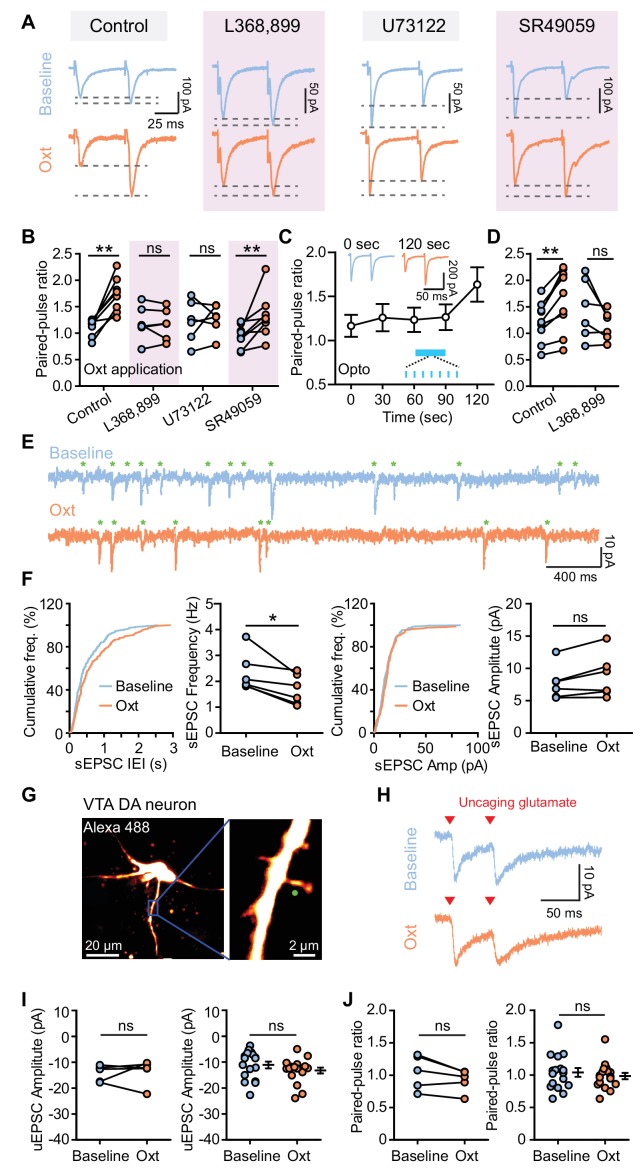
Oxytocin dampens excitatory synaptic transmission by presynaptic mechanisms.(A) Traces from VTA DA neurons showing pairs of EPSCs (50 ms ISI) during baseline (top) and following oxytocin application (bottom). From left to right, example traces reflect: the control condition with no additional compounds, the OxtR antagonist L368,899, the PLC blocker U73122, and the V1aR antagonist SR49059. Traces for each neuron are normalized to the amplitude of the first evoked response in the baseline condition. (B) Summary results show paired-pulse ratio during baseline and following oxytocin application in control condition, in the presence of OxtR antagonist L368,899, PLC blocker U73122, and V1aR antagonist SR49059 separately. **p<0.01, Wilcoxon matched-pairs signed rank test. For each condition respectively, n = 8 neurons from six mice, 6 neurons from five mice, 6 neurons from four mice, and 8 neurons from five mice. (C) Summary results show PPR change of the evoked EPSC of VTA DA neurons in response to light stimulation (marked in blue). n = 9 neurons from six mice. Insets show example pairs of EPSCs (50 ms ISI) from one VTA DA neuron at 0 s (before light stimulation) and 120 s (after light stimulation). (D) Summary data for light stimulation-induced EPSC PPR changes with and without OxtR antagonist (L368,899). **p<0.01, Wilcoxon matched-pairs signed rank test, n = 9 neurons from six mice for control condition, n = 6 neurons from four mice in the presence of OxtR antagonist. (E) Example traces show spontaneous EPSCs (sEPSCs, marked with green stars) during baseline (top) and following oxytocin application (bottom). (F) Left: distributions of sEPSC inter-event intervals (IEI) during baseline and following oxytocin application, with summary data for sEPSC frequency. Right: distributions of sEPSC amplitudes and summary data for sEPSC amplitude during baseline and oxytocin application. *p<0.05, Wilcoxon matched-pairs signed rank test, n = 6 neurons from five mice. (G) Left: projection of a z-stack from a VTA DA neuron filled with Alexa Fluor 488 acquired on a two-photon laser-scanning microscope. Right: higher magnification image of the dendrite. Green circle marks the uncaging spot. (H) Example traces of paired uncaging-evoked EPSCs (uEPSCs) at 50 ms ISI, from one dendritic spine during baseline condition (top) and oxytocin application (bottom). Red triangles mark uncaging time-points. (I) Left: summary data for uEPSC amplitudes in a group of dendritic spines from VTA DA neurons during baseline and following oxytocin application. p=0.813, Wilcoxon matched-pairs signed rank test, n = 5 dendritic spines from 4 neurons in three mice. Right: summary data for all uEPSC amplitudes across conditions. p=0.191, Mann-Whitney test, n = 17 dendritic spines for each condition from 16 neurons in four mice. (J) Same as (I), but for paired-pulse ratio. Error bars reflect SEM.10.7554/eLife.33892.010Figure 2—source data 1.Summary tables of paired pulse ratios of evoked EPSCs, inter-event intervals of spontaneous EPSCs, and amplitudes of uncaging-evoked EPSCs.